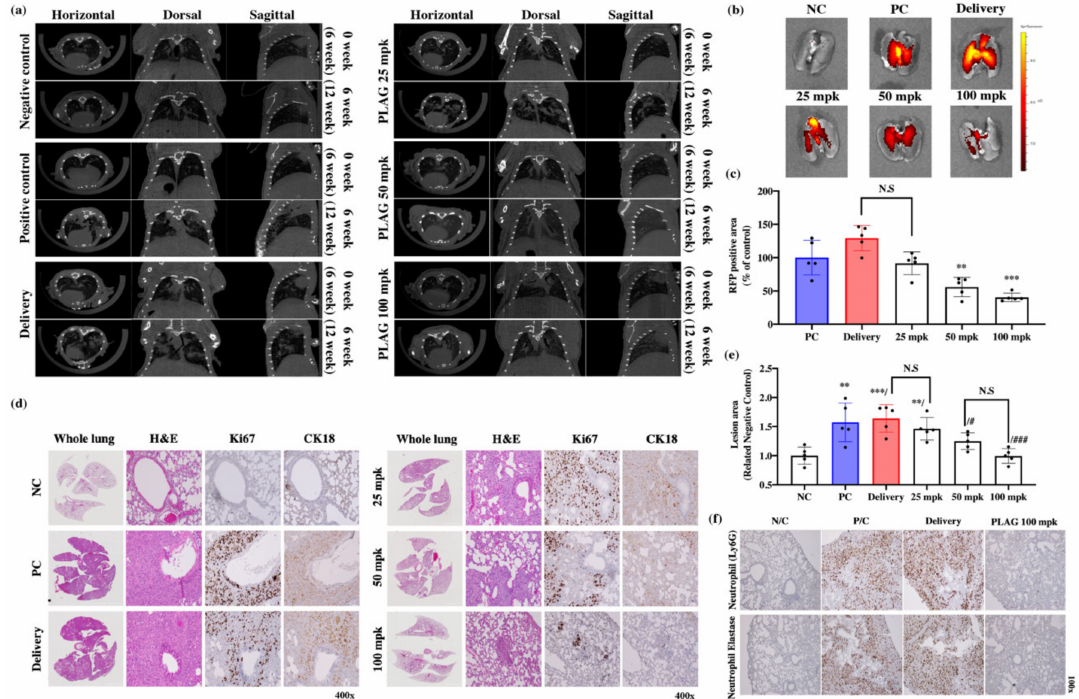
Figure 3. Inhibitory e ff ects of PLAG on A549 human lung cancer cells implanted in mice: ( a ) Orthotopic tumor cell proliferation in mouse lungs determined by CT imaging; ( b , c ) Orthotopic tumor cell proliferation in mouse lungs determined by IVIS imaging. Compared with the negative control group: ** p < 0.01, *** p < 0.001 (each experiment n = 5). N.S., not significant. Mean ± SD; ( d ) Evaluation of the main tumor region in PLAG-treated lung tissues after implantation with A549 cells. The volume of alveolar space occupied by tumor cells was measured and compared with that in negative control mice using Image J. Compared with the negative control group: ** p < 0.01, *** p < 0.001. N.S., not significant. Compared with the positive control group: # p < 0.05, ## p < 0.01 (each experiment n = 5). N.S., not significant. Mean ± SD; ( e ) Tumor growth in PLAG-treated lung tissues evaluated by H&E staining and immunohistochemical staining with anti-Ki67 and anti-CK18 antibodies 14 weeks after implantation; ( f ) Labeling with anti-neutrophil and neutrophil elastase antibody showed that